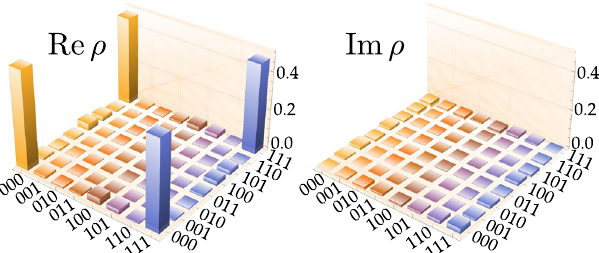
Fig. 6 Real and imaginary parts of the experimental recon- structed GHZ state. Colors are for visualization purposes